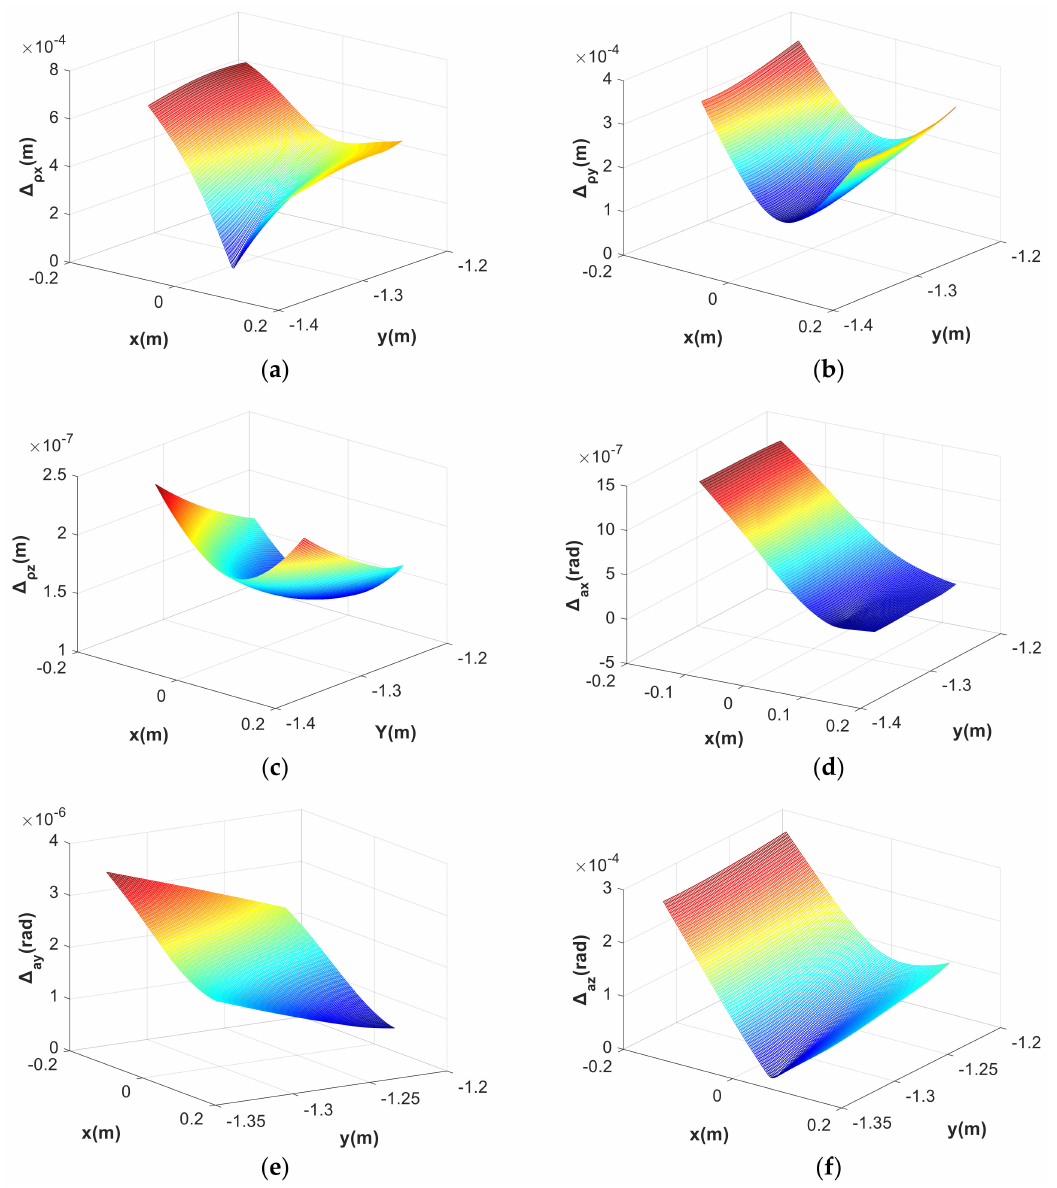
Figure 9. Deformation distributions of the mechanism in the sub-workspace of type I. ( a ) Linear deformation distribution in x direction of type I; ( b ) Linear deformation distribution in y direction of type I; ( c ) Linear deformation distribution in z direction of type I; ( d ) Angular deformation distribution in x direction of type I; ( e ) Angular deformation distribution in y direction of type I; ( f ) Angular deformation distribution in z direction of type